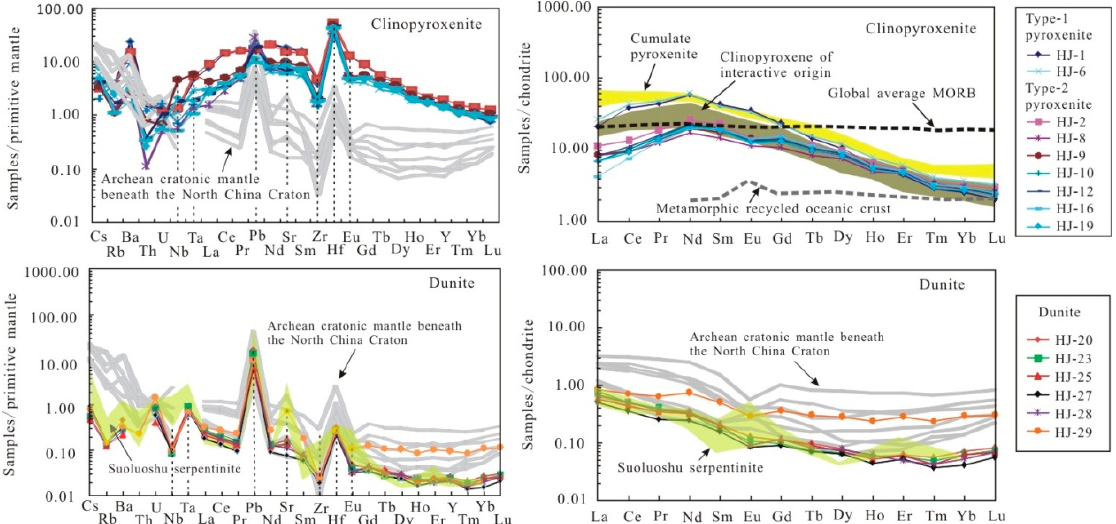
Figure 10. Primitive mantle-normalized trace elements and chondrite normalized REE for Hujialin pyroxenite and dunite in Sulu orogen. Archean cratonic mantle beneath the North China Craton [40], Suoluoshu serpentinite [3], global average MORB [52], cumulate pyroxenite [53], reactive clinopyrox- ene [36], and metamorphic recycled oceanic crust [54,55] are listed for comparison. Data of primitive mantle and chondrite are from McDonough and Sun